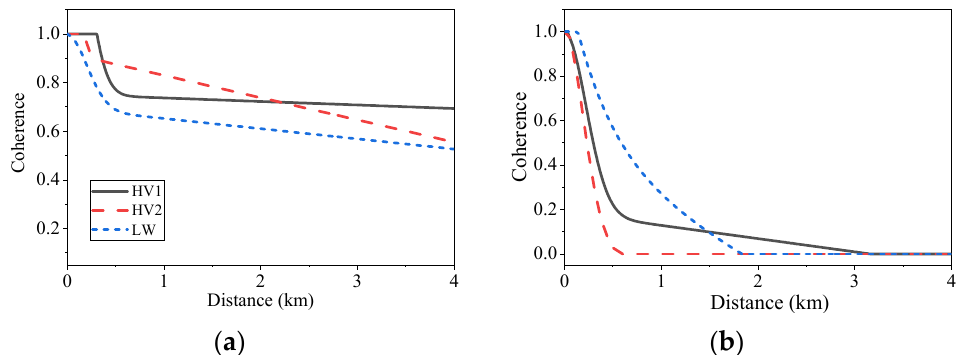
γ = 6 N : ( a ) ζ γ = 6 N lj : ( a ) ζ lj